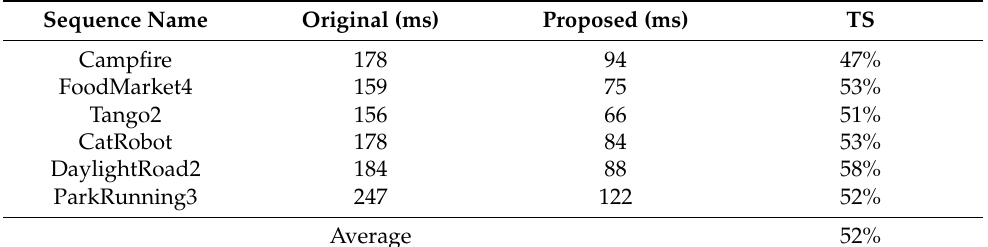
Table 6. Comparison of the extraction times for HEVC bitstreams.